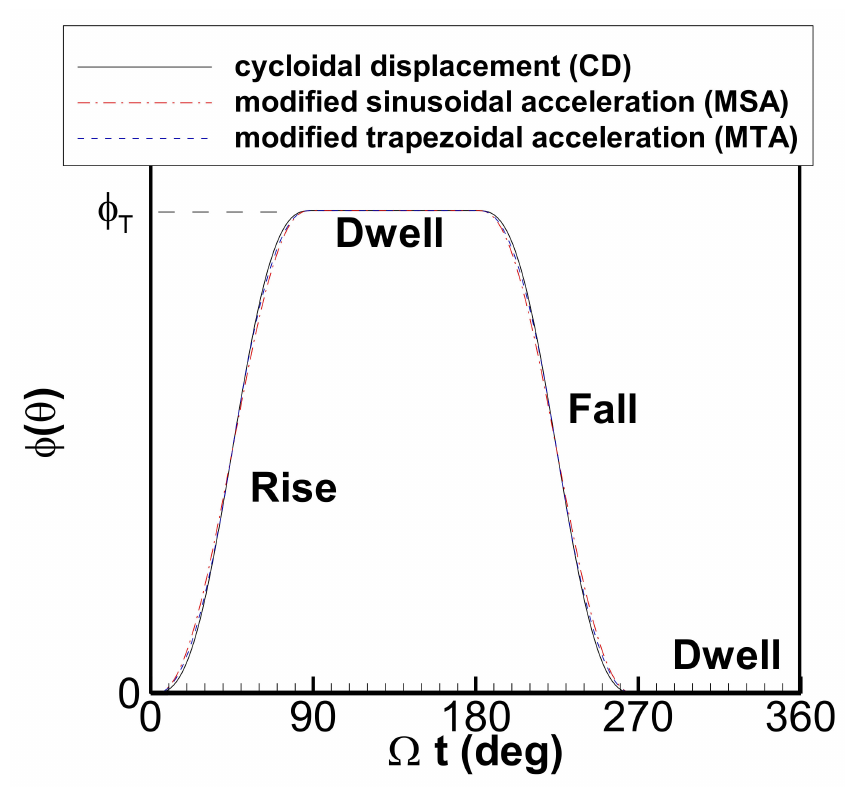
Figure 3. Three motions of the rise-dwell-fall-dwell motion of the oscillating